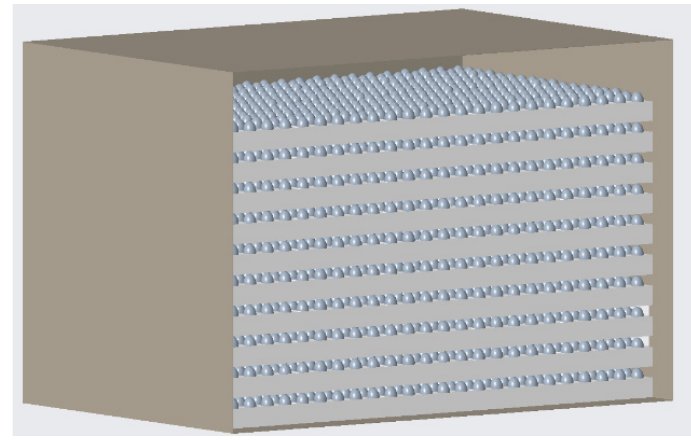
Figure 1. Geometric model of the air adjuster.